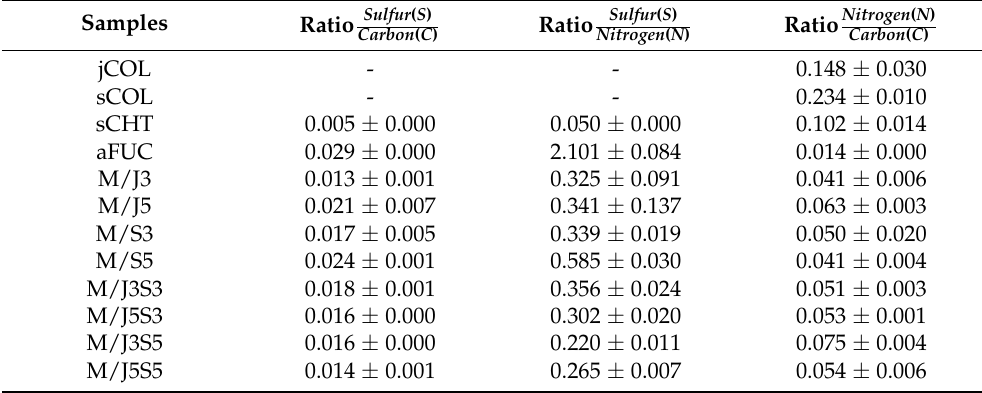
Table 1. Average and standard deviation of the atomic concentration ratios between sulfur/carbon, sulfur/nitrogen and nitrogen/carbon on the surface of each biopolymers studied and on the devel- oped